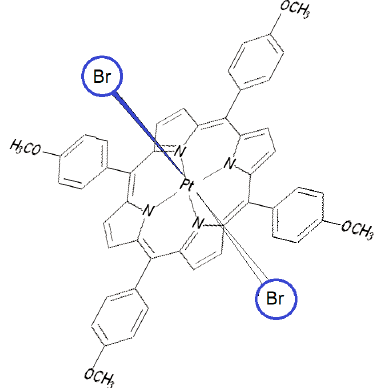
Figure 6. Sensing of bromide ions by their axial coordination to platinum metal in the center of porphyrin above and below the plane of the molecule by a Lewis acid–base reaction.